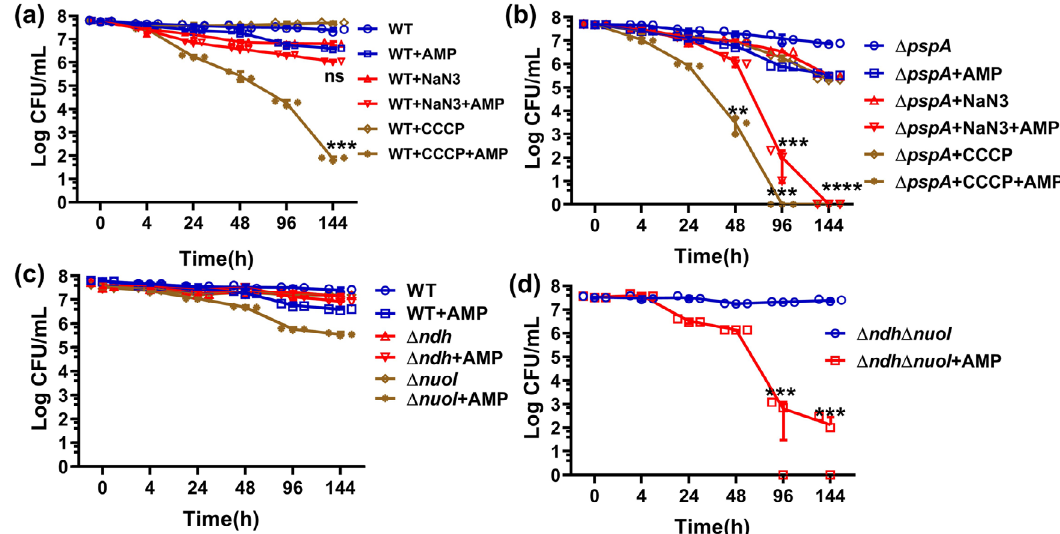
Fig. 3 PMF is essential for maintaining the tolerance phenotype in bacteria under starvation. a Population size of E. coli strain BW25113 was recorded at different time points upon starvation for 24 h, followed by treatment with ampicillin, sodium azide, CCCP, or various combinations of such compounds. P values were tested between WT + NaN3 and WT + NaN3 + AMP, WT + CCCP, and WT + CCCP + AMP at 144 h. b Population size of the Δ pspA gene knockout mutant recorded at different treatment time points upon starvation for 24 h and then treated with ampicillin, sodium azide, CCCP, or various combinations of such compounds. P values were tested between Δ pspA + NaN3 and Δ pspA + NaN3 + AMP, Δ pspA + CCCP and Δ pspA + CCCP + AMP at indicated time points. c E. coli strain BW25113 and the corresponding Δ ndh and Δ nuoI gene knockout mutants and double gene knockout mutant Δ ndh Δ nuoI d were starved for 24 h, followed by treatment with ampicillin for 144 h. Changes in population size during the course of 144 h are shown, along with data recorded in a no ampicillin treatment control. n = 3 biologically independent experiments. ns indicates no signi fi cance, **indicate a P value of <0.01, ***indicate a P value of <0.001, ****indicate a P value of <0.0001 by two-tailed Student ’ s test. Error bar represents standard